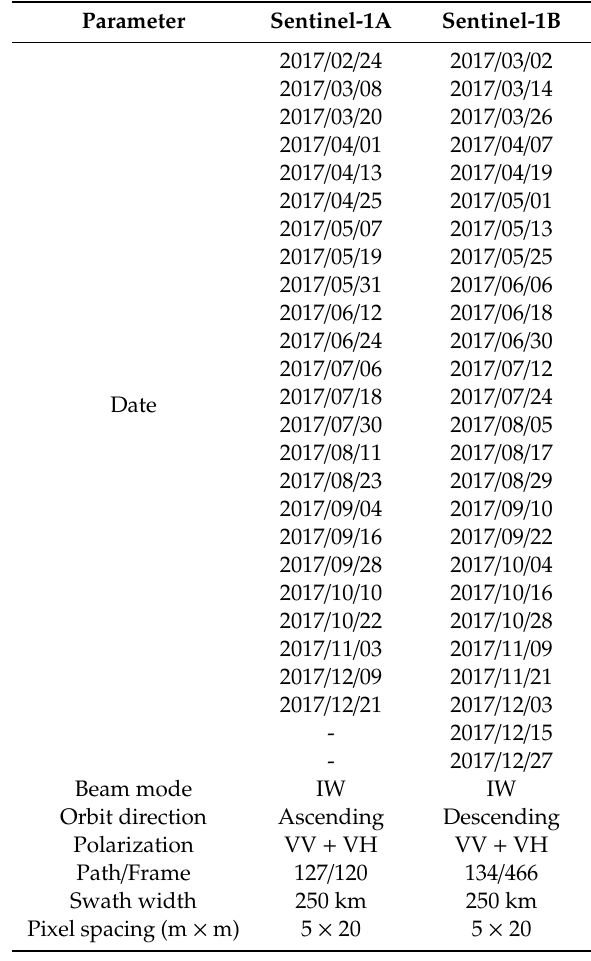
Table 3. List of Sentinel-1A and -1B data and their acquisition parameters. Parameter Sentinel-1A Sentinel-1B